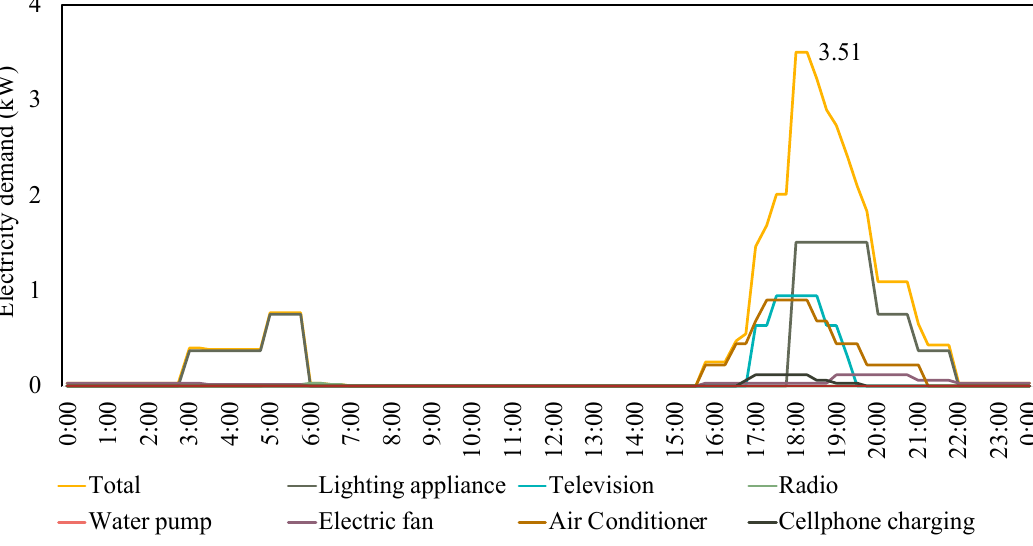
Figure 7. Current electricity demand daily load pattern of the Indonesian case study (during the warm season).